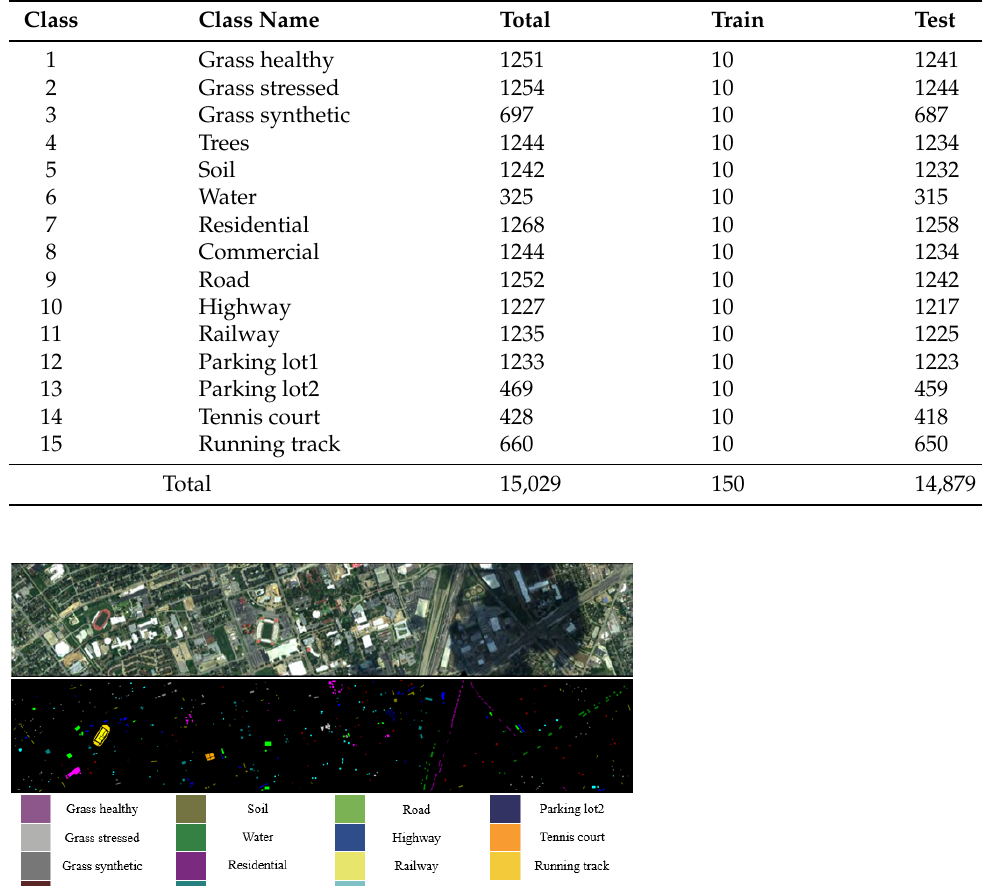
Table 3. The numbers of the training and testing sampling for the Houston dataset.